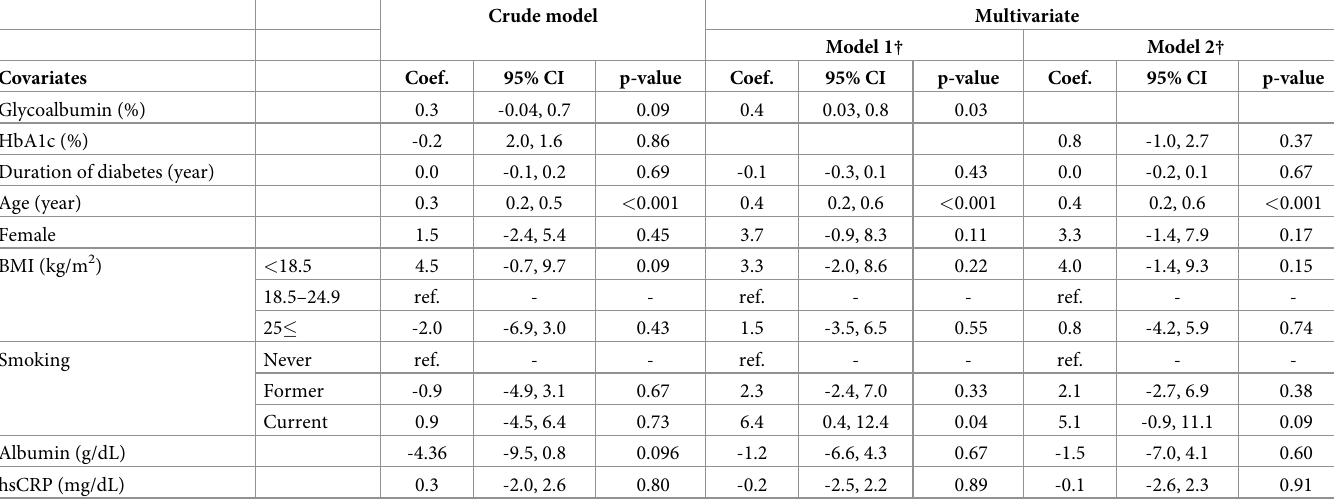
Table 5. The factors associated with the number of missing teeth in patients with type 2 diabetes mellitus (n =